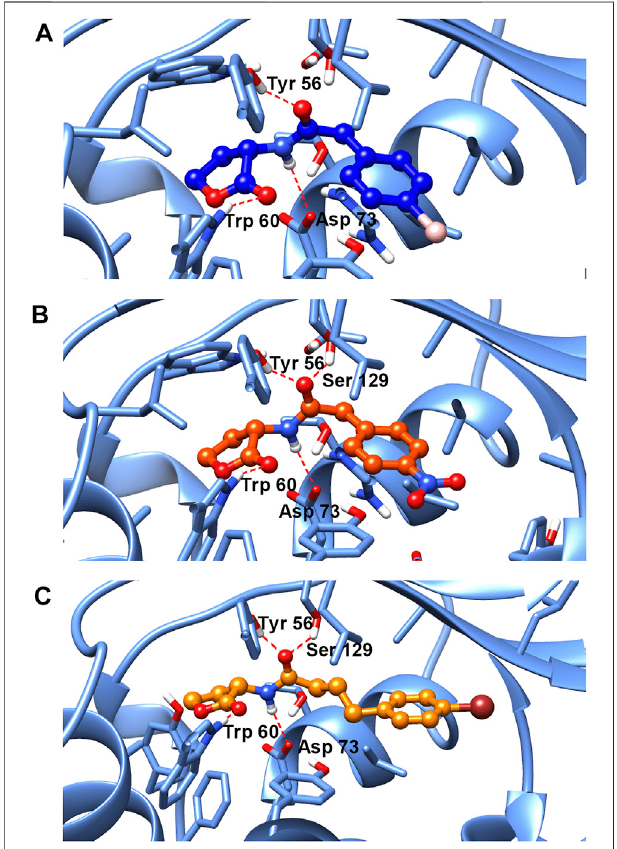
FIGURE 9 | Molecular docking of (A) compound no.1, (B) compound no.3, and (C) compound no.10 into the active site of LasR. Both compound no.3 and compound no.10 interacted with LasR by formation of H-bonding withtheTry56,Trp60,Asp73,andSer129.Compoundno.1interacted with LasR with Try 56, Trp 60, and Asp 73 by